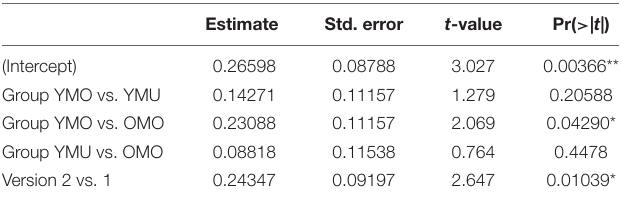
FIGURE 6 | Distributions of D -scores (pronunciation effect, y -axis) as a function of listener group (YMU, YMO, and OMO) and order (test version v1, v2) for the KD-experiment.